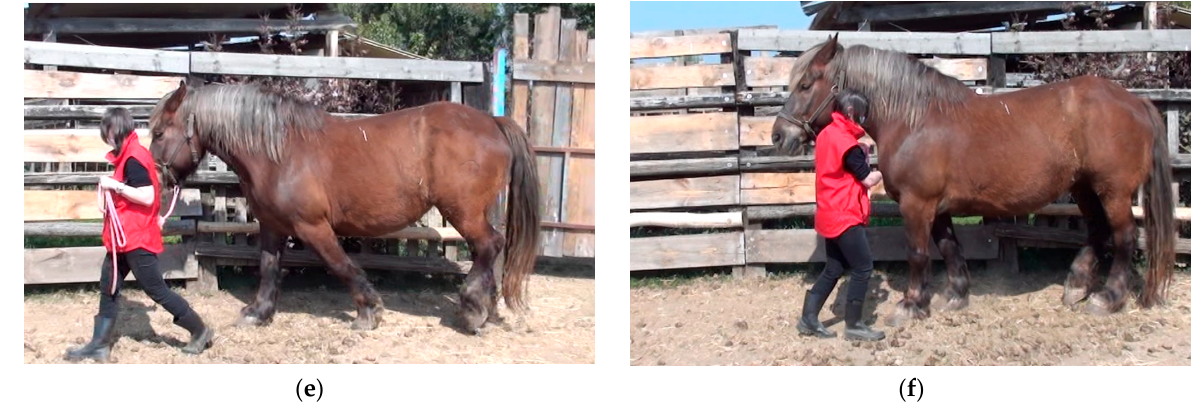
Figure 1. The Broken/Unbroken Test (BUT) consists of two phases: in the first phase ( a – d , Approaching and Haltering), the tester entered the test area, walked towards the horse slowly with the halter in her hand, approached the horse, and then tried to halter it; in the second phase ( e , f , Handling), which was only attempted if it had been possible to complete the first phase within 5 min, the tester tried to lead the horse three steps forwards and three steps backwards. In a real setting, the tester should wear protective equipment.